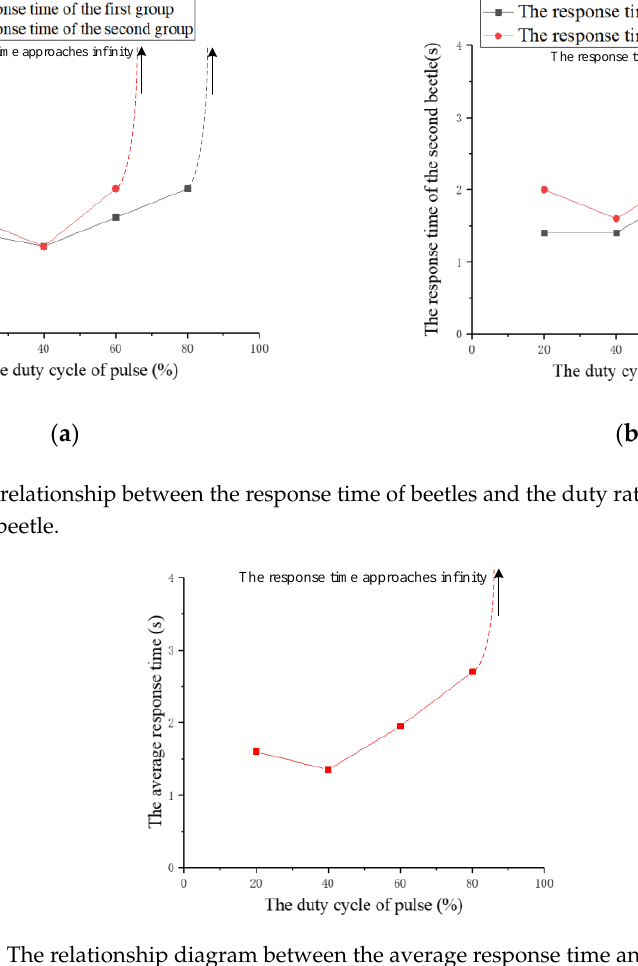
Figure 14. The relationship diagram between the average response time and the duty ratio.